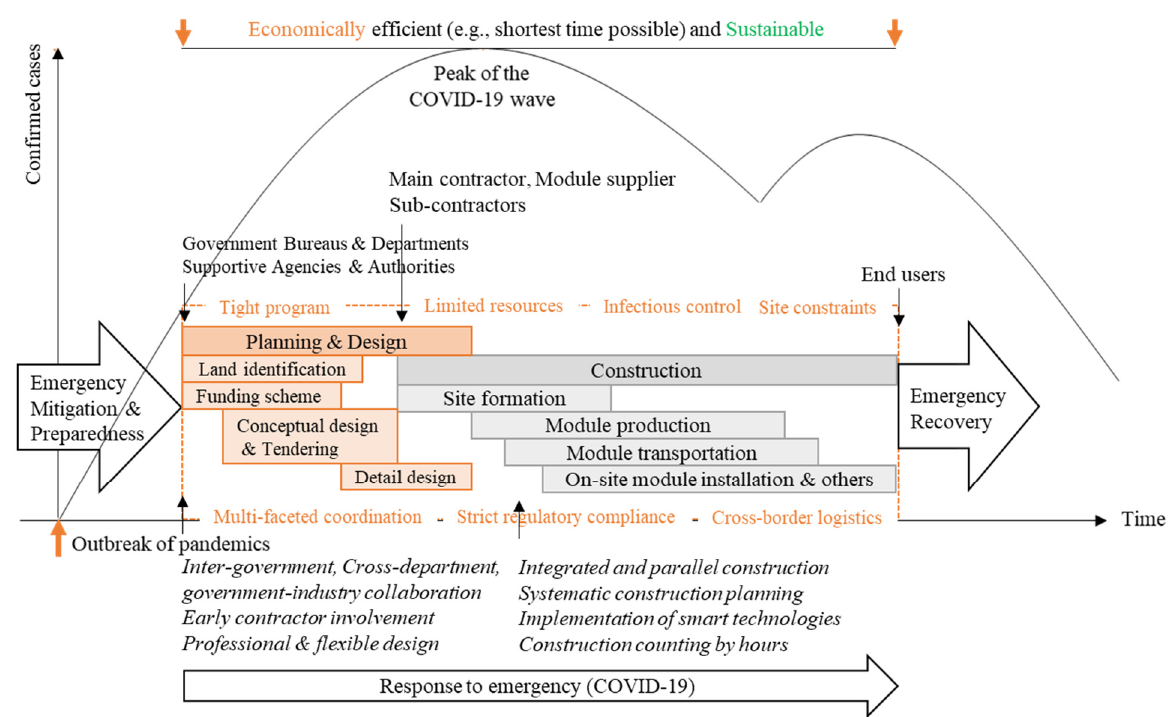
Figure 8. Framework of modular construction-enabled efficient response to COVID-19.